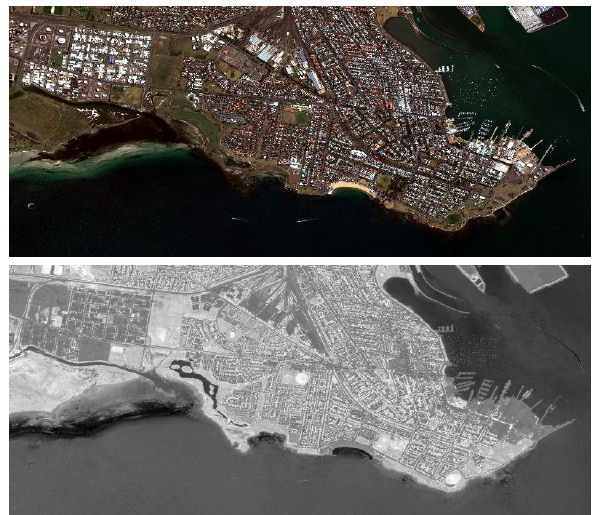
Figure 2. True colour satellite image (top) and NDVI image (bottom).